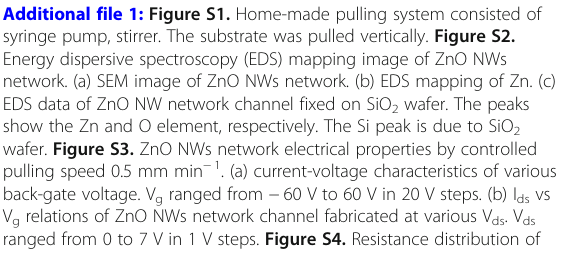
Additional file 1: Figure S1. Home-made pulling system consisted of syringe pump, stirrer. The substrate was pulled vertically. Figure S2. Energy dispersive spectroscopy (EDS) mapping image of ZnO NWs network. (a) SEM image of ZnO NWs network. (b) EDS mapping of Zn. (c)